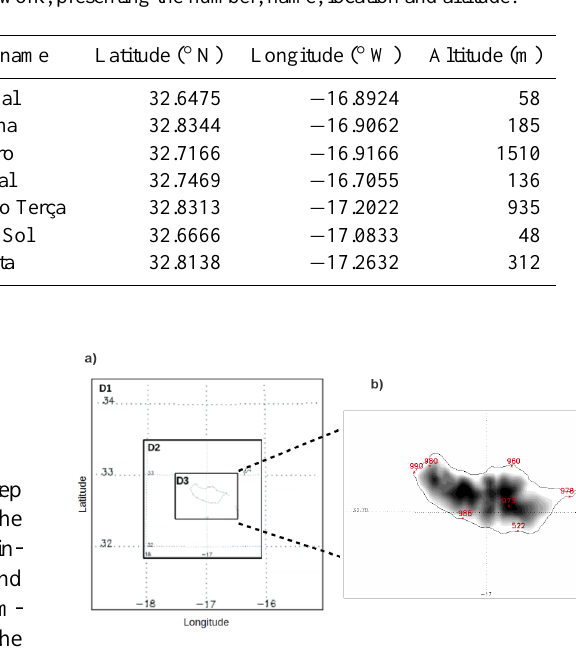
Figure 1. (a) horizontal domains used in the simulations with grid spacing of 9 km (D1), 3 km 2 Fig. 1. (a) Horizontal domains used in the simulations with (D2) and 1 km (D3), (b) The shaded areas represent the 1km orography (m) obtained from the 3 grid spacing of 9km (D1), 3km (D2) and 1km (D3). (b) The GTOPO30 database. Points (Station): 522 (Funchal), 960 (Santana), 973 (Areeiro), 978 4 shaded areas represent the 1km orography (m) obtained from the (Caniçal), 980 (Lombo da Terça), 986 (Ponta do Sol), 990 (Calheta). 5 GTOPO30 database. Point (station): 522 (Funchal), 960 (Santana), 973 (Areeiro), 978 (Canic¸al), 980 (Lombo da Terc¸a), 986 (Ponta do Sol), 990